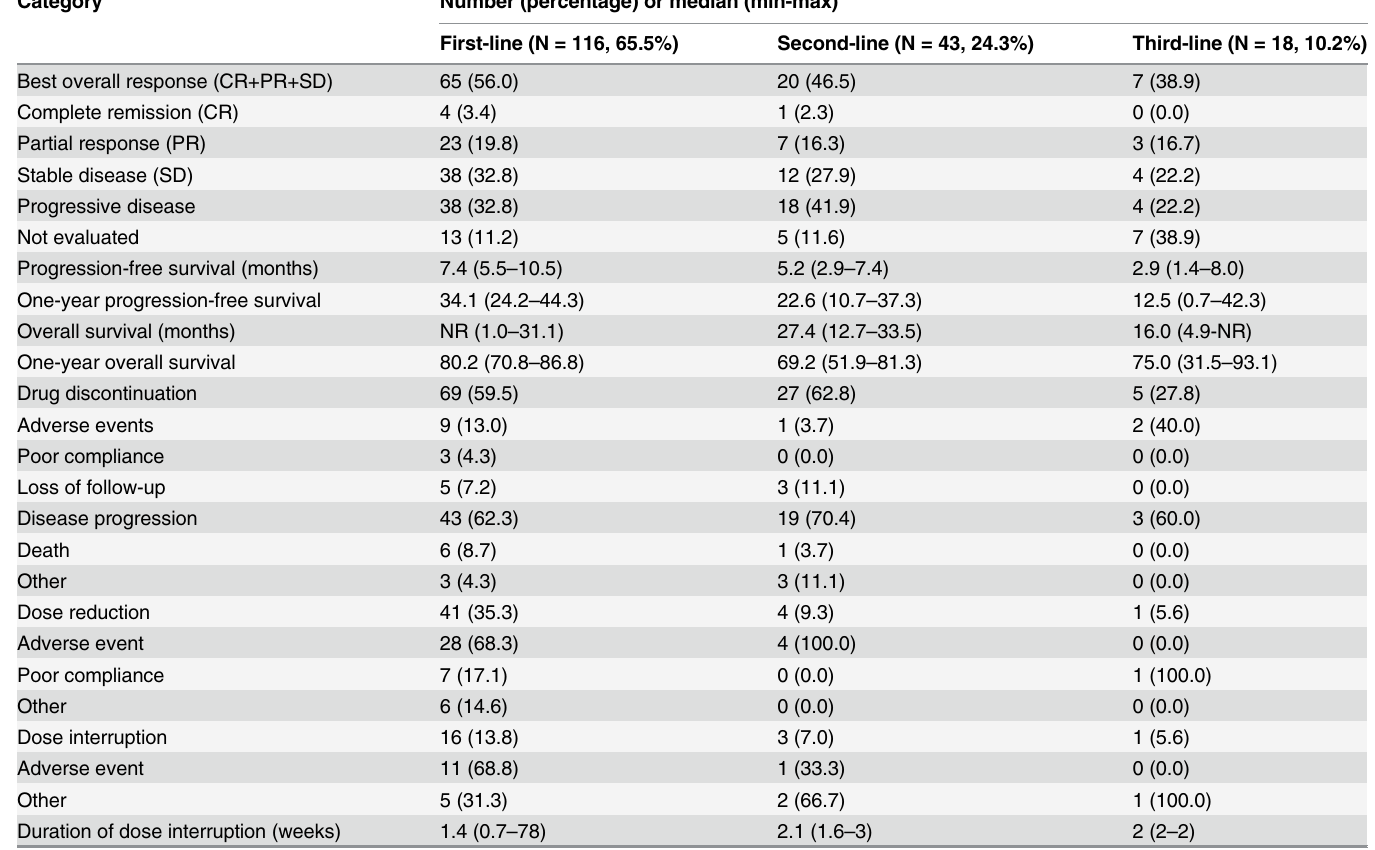
Table 3. Therapeutic responses to sorafenib according to the treatment